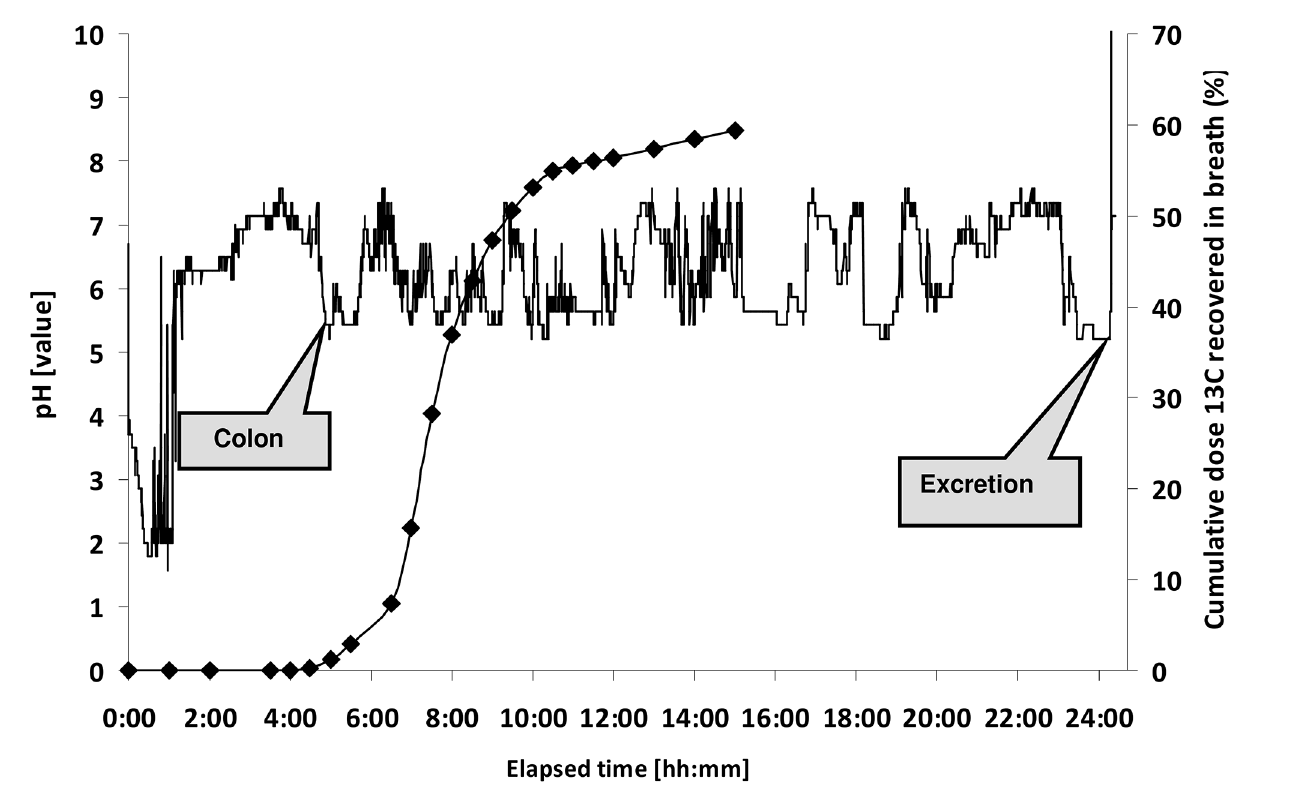
Fig 5. Colon arrival time based on pH (-) corresponds with release of 13 C ( ♦ ) (subject 14). See also Fig 4 for the first 10